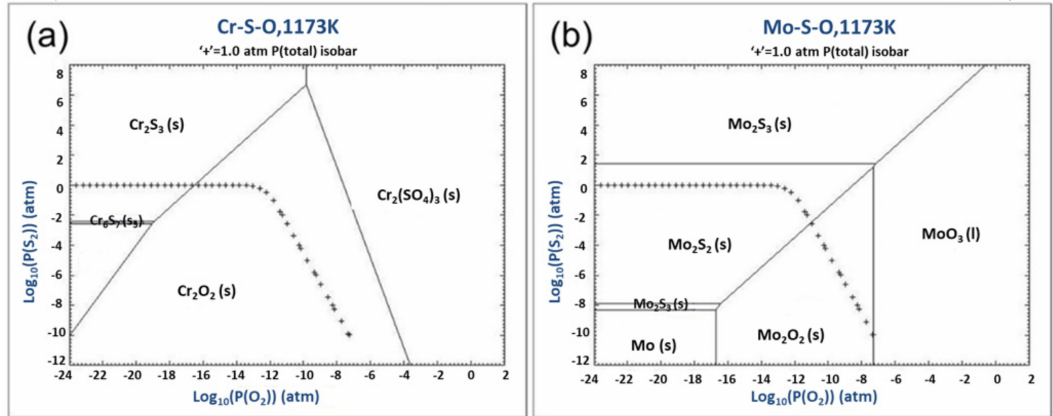
Figure 11. The schematic diagram of the formation of sulfides and oxides under di ff erent gas partial pressures [54]. ( a ) Cr-S-O ternary phase composition. and ( b ) Mo-S-O ternary phase